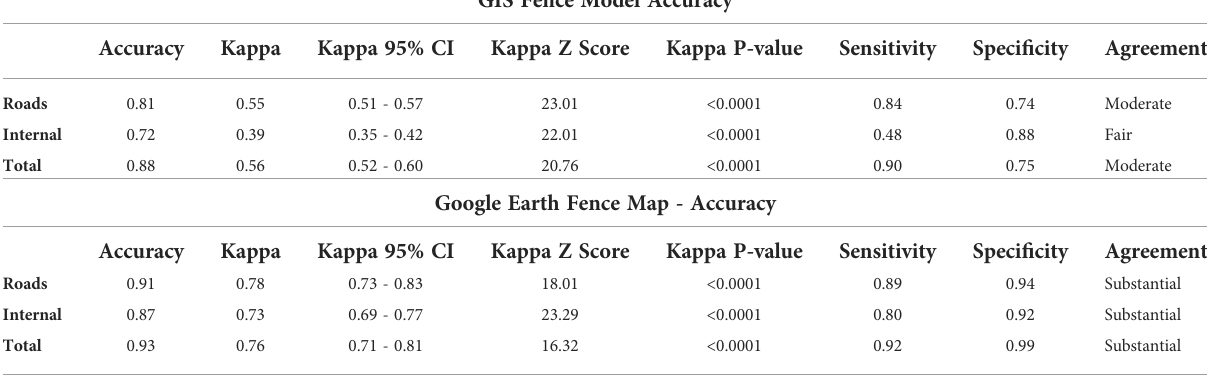
TABLE 1 Accuracy assessment results for the GIS fence location model and the Google Earth fence digitization map.